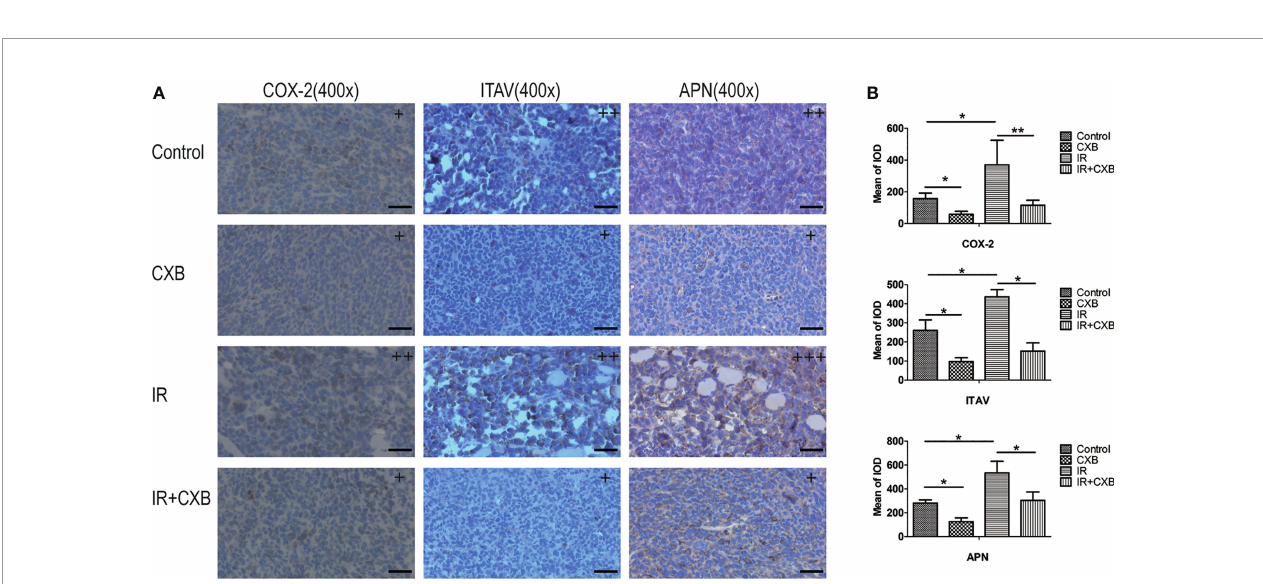
FIGURE 7 | Con fi rmation of off-targets of CXB in LLC xenografts. (A) The COX-2, ITAV, and APN protein expression in tumor tissues was assayed by immunohistochemistry (the control, CXB, IR, and IR plus CXB groups). The nucleus was stained blue; and the COX-2, ITAV, and APN expression were stained brown. +, ++, and +++: The subjective scores of the tissue sections by immunohistochemical staining of COX-2, APN, and ITAV, respectively. Scale bar, 300 m m. (B) The mean of IOD test (the LLC xenografts in C57 mice). * p < 0.05, ** p < 0.01. CXB, celecoxib; LLC, Lewis lung cancer; COX-2, cyclooxygenase-2; ITAV, integrin alpha-V; APN, aminopeptidase N; IR,